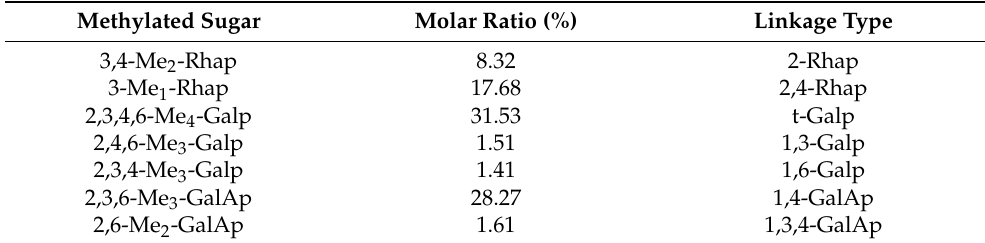
Table 4. Methylation analysis and mode of linkage of